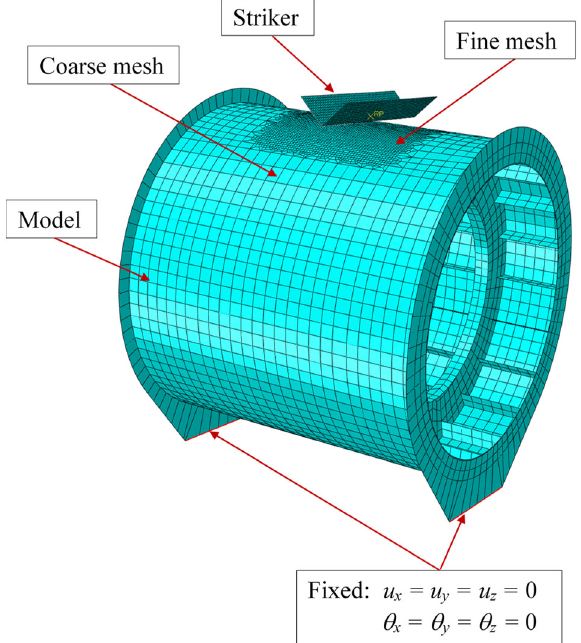
Figure 1. Finite element modelling of the stringer-stiffened cylinder.